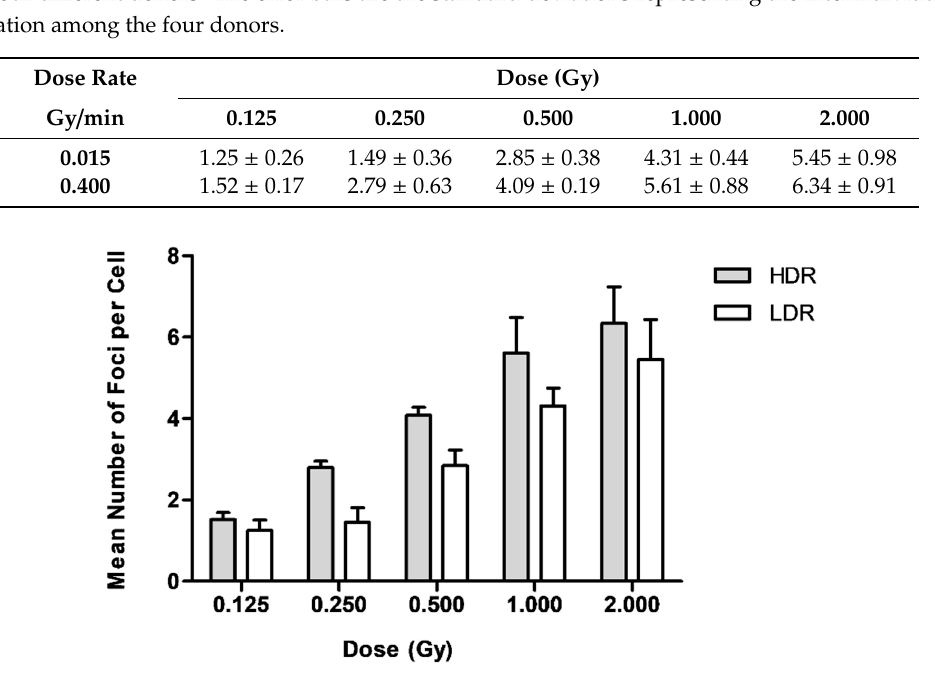
Figure 1. The number of γ -H2AX foci as a function of dose for lymphocytes exposed to HDR (0.400 Gy/min) and LDR (0.015 Gy/min) neutrons. Data represents the mean number of γ -H2AX foci ± standard deviation of four healthy volunteers over two independent experiments.